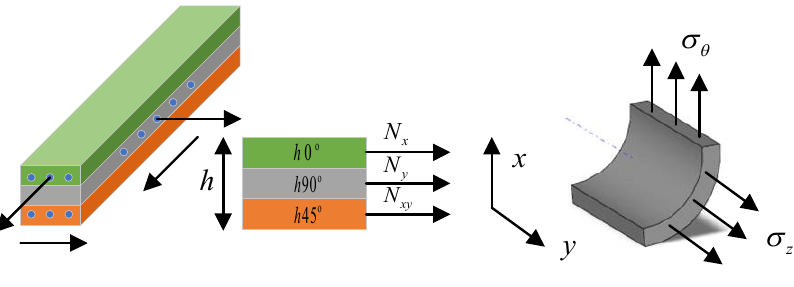
Figure 4. Laminate and cylinder reference system.